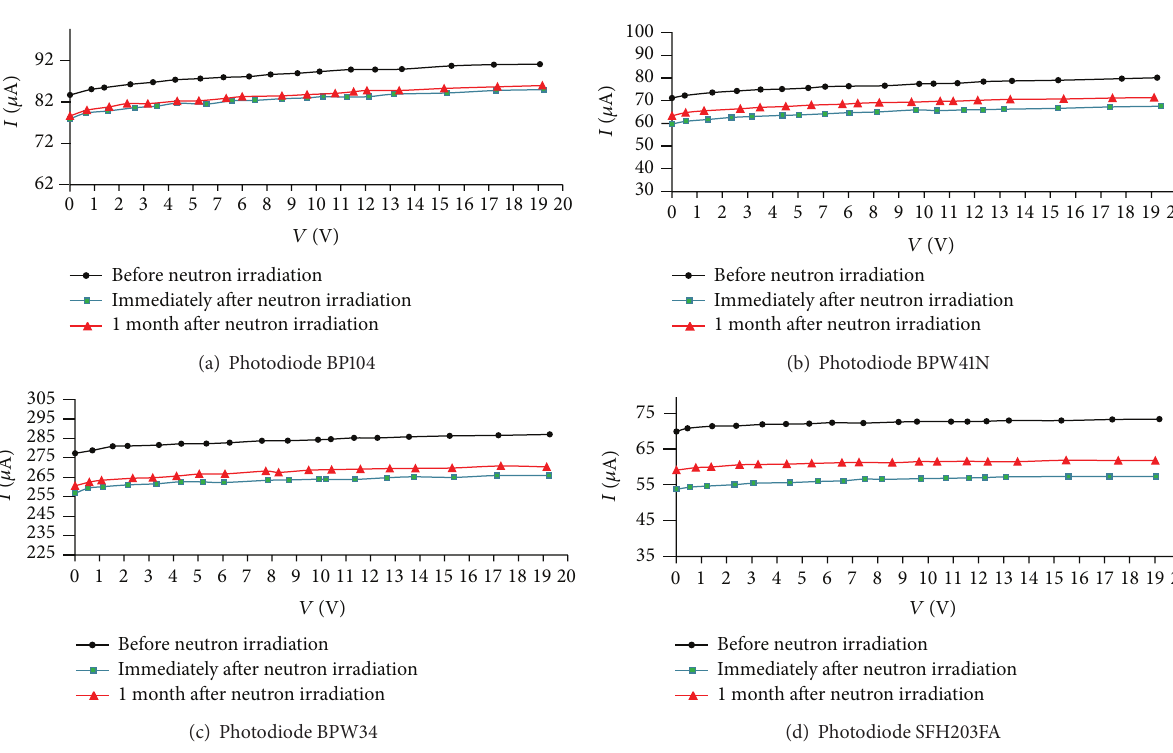
Figure 2: 𝐼 - 𝑉 characteristics of the reverse biased photodiodes before and after neutron irradiation.